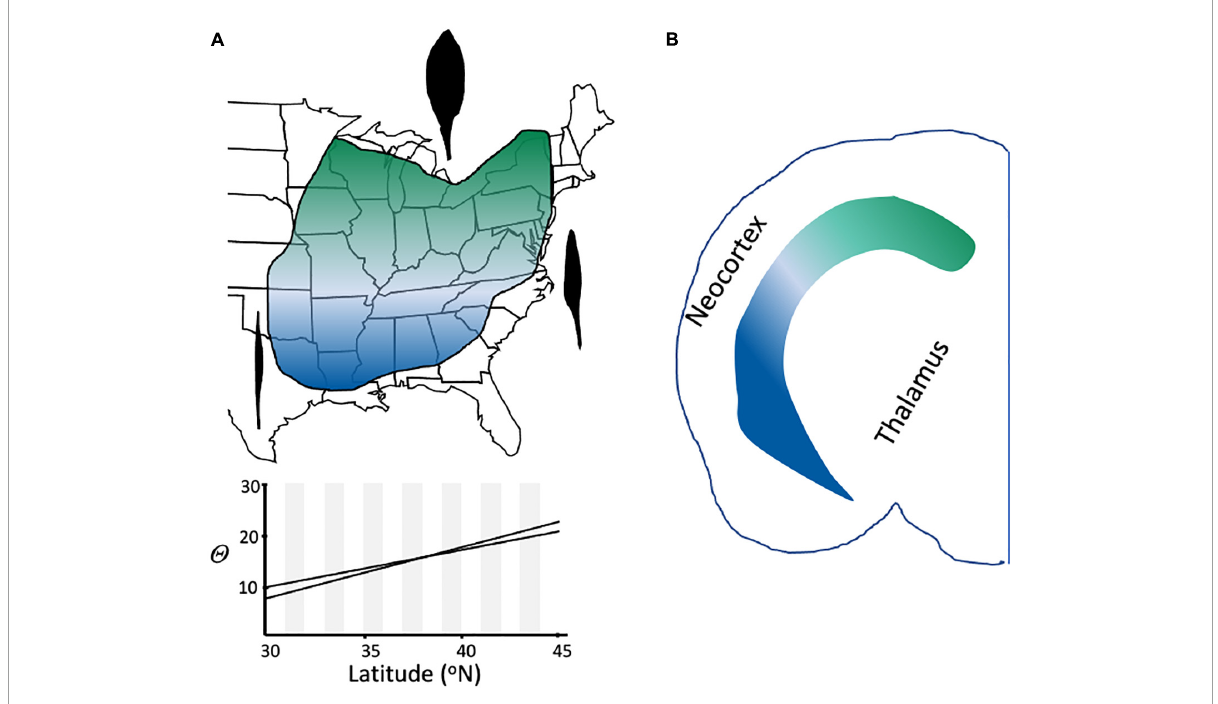
FIGURE8 Clinal variation in species and cell types. (A) Leaf shape variation in Claytonia virginica (Doyle, 1984). Representative leaf shapes are shown as black outlines, with broad leaves being characteristic in the northern part of the range, very narrow, grasslike leaves in the extreme southern portion of the range, and intermediate shapes at intermediate latitudes in eastern North America. The 95% confidence interval of the relationship of theta (arcsin [length/width] 1 / 2 ) to latitude is shown for 462 individuals ( r = 0.49; p < 0.001). (B) Continuous variation in cell type in the mouse brain (redrawn from Cembrowski and Menon, 2018). Expression of dorsal (green) and ventral (blue) marker genes for two different cell types of the hippocampus show a gradient of expression across the